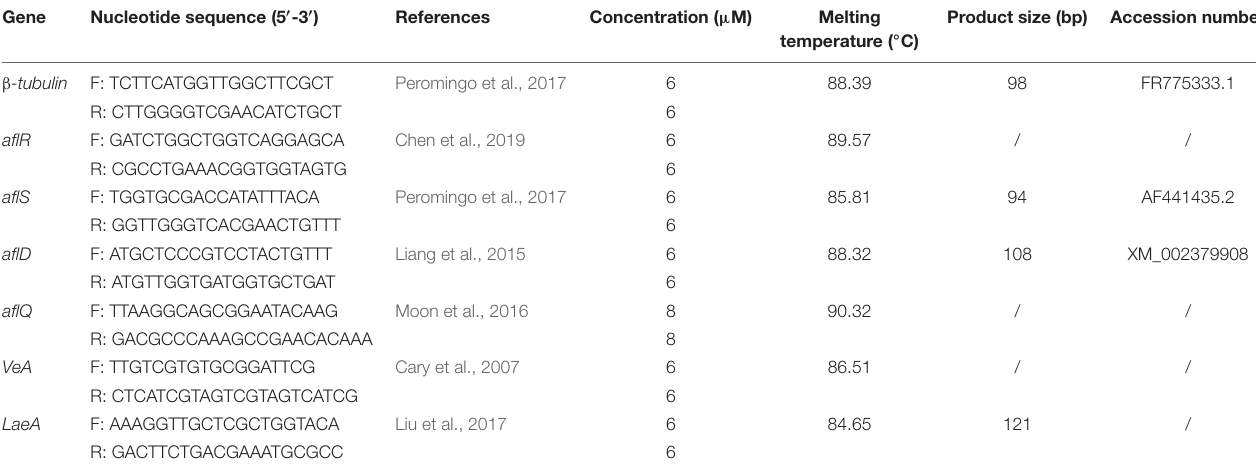
TABLE 1 | Nucleotide sequences of primers for RT-qPCR assays. Gene Nucleotide sequence (5 (cid:48) -3 (cid:48)